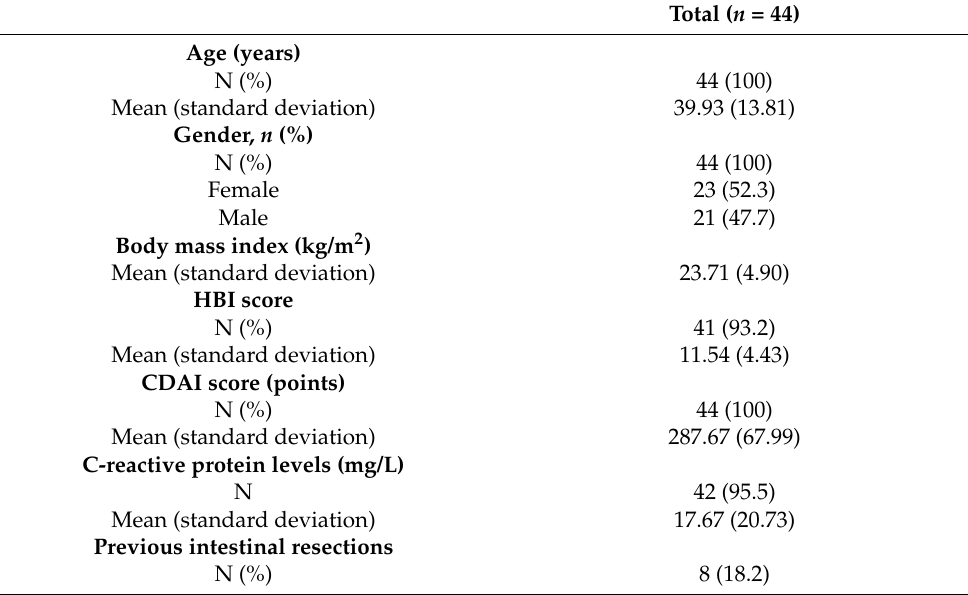
Table 1. Baseline demographic and clinical characteristics of patients with Crohn ´ s disease. Table 1 . Baseline demographic and clinical characteristics of patients with Crohn´s disease.